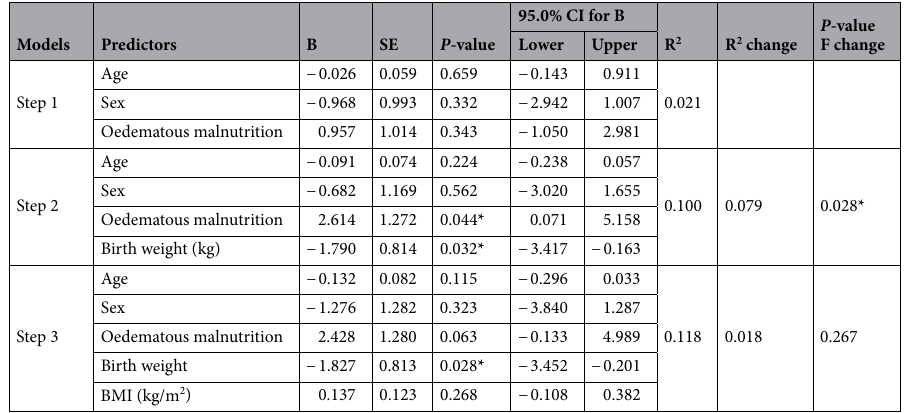
Table 2. Hierarchical multiple regression analysis of variables predicting mean liver attenuation in 88 adult survivors of severe acute malnutrition. * P < 0.05. B unstandardized regression coefficient, SE standard error, P p -value for the unstandardized regression coefficient for the model, CI confidence intervals, R 2 coefficient of determination, R 2 change the improvement in R-square when a predictor is added, P-value F-change p-value for the test of the R 2 change. Coding for sex was male (0) and female (1). Coding for SAM diagnosis was oedematous malnutrition (1) and severe wasting (2). Mean liver attenuation has an inverse association with liver